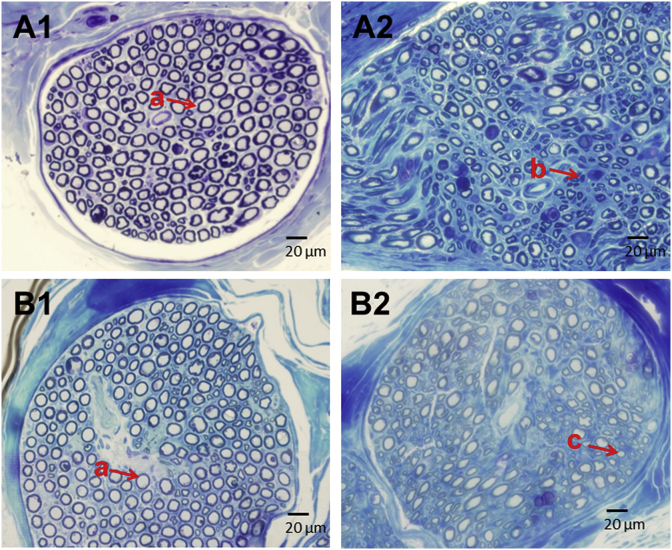
Histology of tibial nerve in individual nerve repair (INR) model. Tibial nerve distal to the nerve transection repair site was harvested, cut into semi-thin (1 μm) sections and stained with Toluidine Blue. Cross section images (400x) were used for comparison by light microscopy. A1, Left tibial naïve nerve untransected and vehicle-treated - numerous axons tightly packed and surrounded by distinct myelin sheaths; A2, Right tibial transected and repaired nerve vehicle-treated - fewer axons, less distinct, reduced myelination, reduced nerve fiber density, increased axonal degeneration, and some regenerating axons (small diameter). B1, Left tibial naïve nerve untransected and MSC treated – numerous axons tightly packed and surrounded by distinct myelin sheath as in A1; B2, Right tibial transected and repaired nerve MSC treated – increased large size axons, nerve fiber density, myelination and regenerating axons, and reduced axonal degeneration compared to vehicle-treated control A2. a, normal axons (axons visible as blue annulae with myelination evident); b, degenerating axons (axons less distinct, myelination decreased, and myelin debris evident); c, regenerating axons (axons visible with distinct myelination and more nerve fiber density); MSC, mesenchymal stem cells. (For interpretation of the references to colour in this figure legend, the reader is referred to the Web version of this article.)